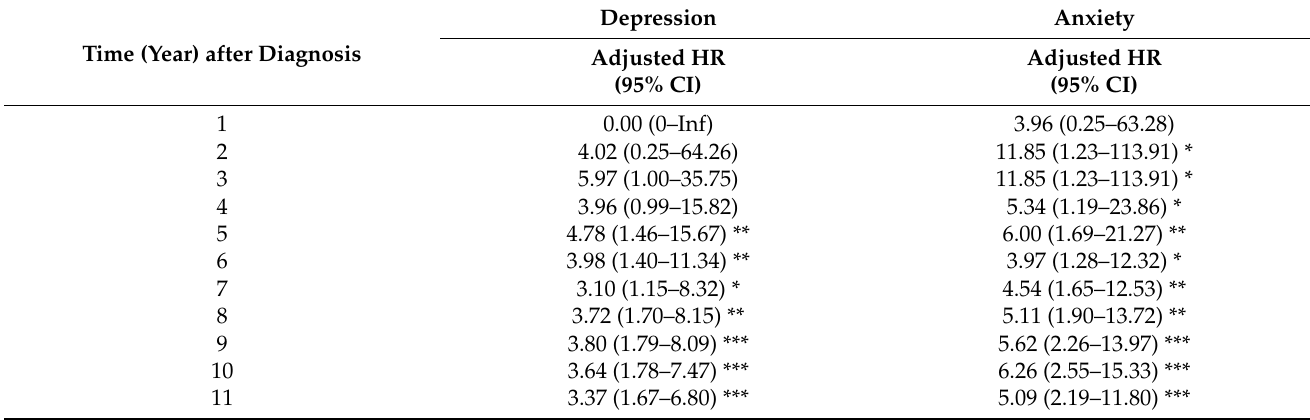
Table 7. Risk ratio of burning mouth syndrome event by time elapsed since the diagnosis of depres- sion or anxiety.